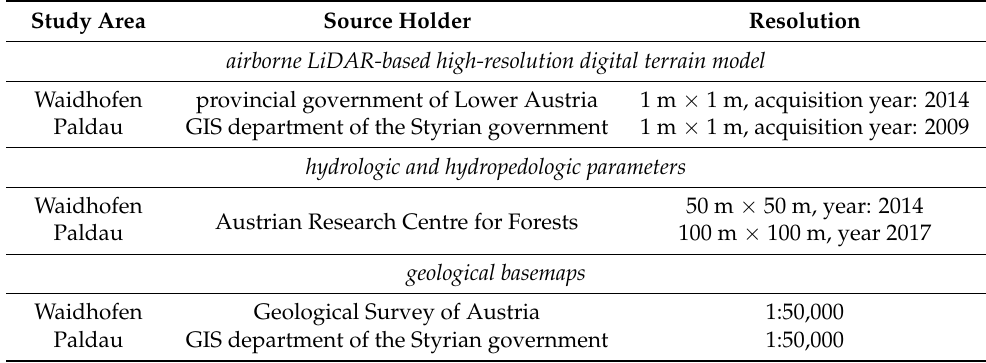
Table A1. Sources of land surface data.